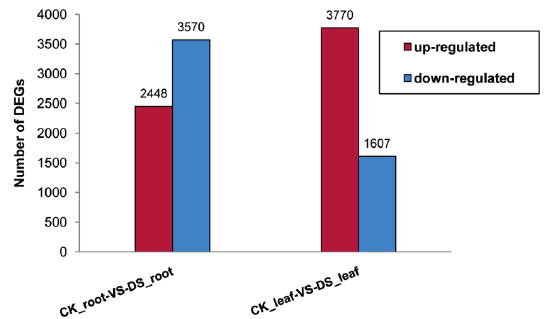
Figure 1. Changes in gene expression in Root and Leaf libraries. Numbers of up-regulated and down-regulated genes were summarized. CK_root-VS-DS_root refers to number of differentially expressed genes in root in response to drought stress; CK_leaf-VS-DS_leaf refers to number of differentially expressed genes in leaf in response to drought stress.